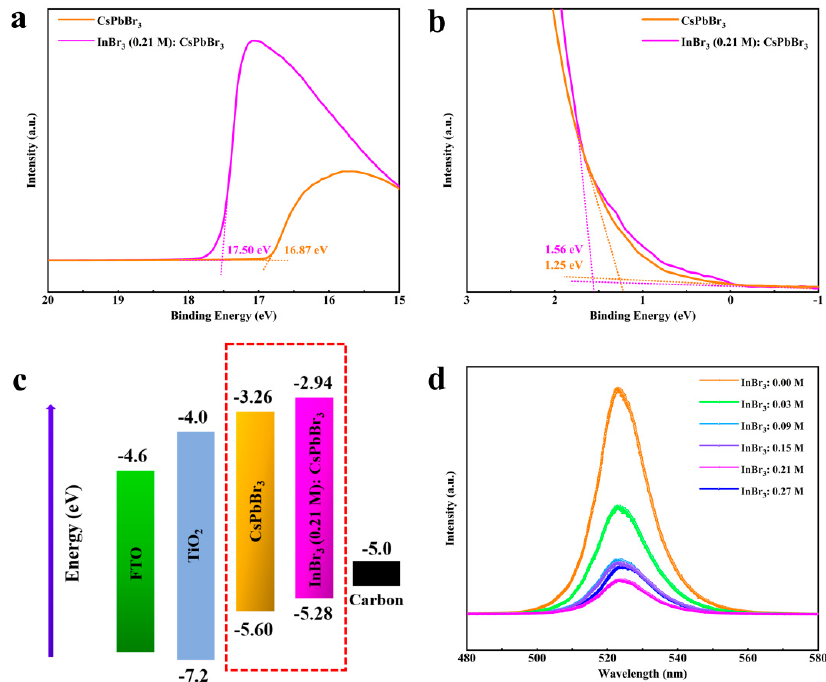
Figure 5. ( a , b ) UPS spectra of the pristine and InBr 3 (0.21 M):CsPbBr 3 films. The linear fittings indicate the photoemission cutoff energy boundary (E cutoff ) and onset (E onset ) values. ( c ) Energy level diagram for the carbon-based pristine and InBr 3 (0.21 M):CsPbBr 3 PSCs. ( d ) PL spectra of the cells by introducing different concentrations of InBr 3 .